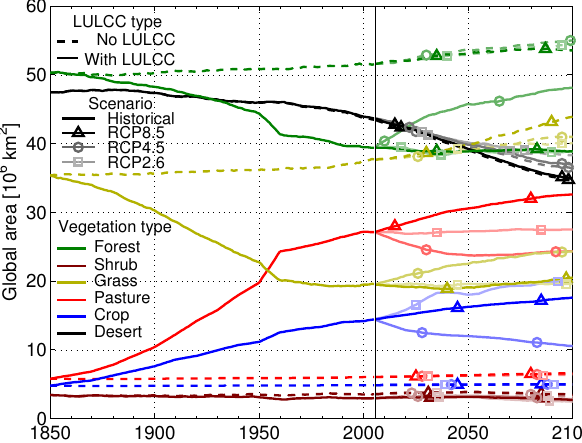
Figure 1. Evolution of the global area of different vegetation and surface types resulting from gross and no LULCC combined with dynamic vegetation. Different experiments have different line styles, different surface types have different colour and different scenarios have different brightness (same brightness for histori- cal and RCP8.5, since they do not have any temporal overlap). Desert: area without vegetation under current climate. Glacier and bare rock area which can never have vegetation is constant about ∼ 16 × 10 6 km 2 throughout the